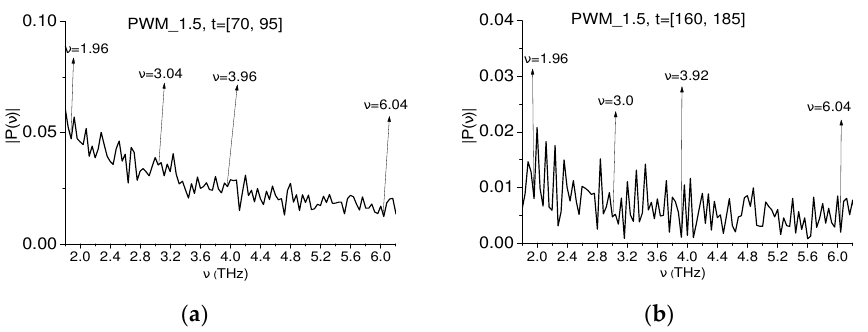
Figure 21. Fourier spectra of the PWM_1.5 s ( a ) and third ( b ) sub-pulses in the time intervals t = [70, 95] ps ( a ), [160, 185] ps ( b ),